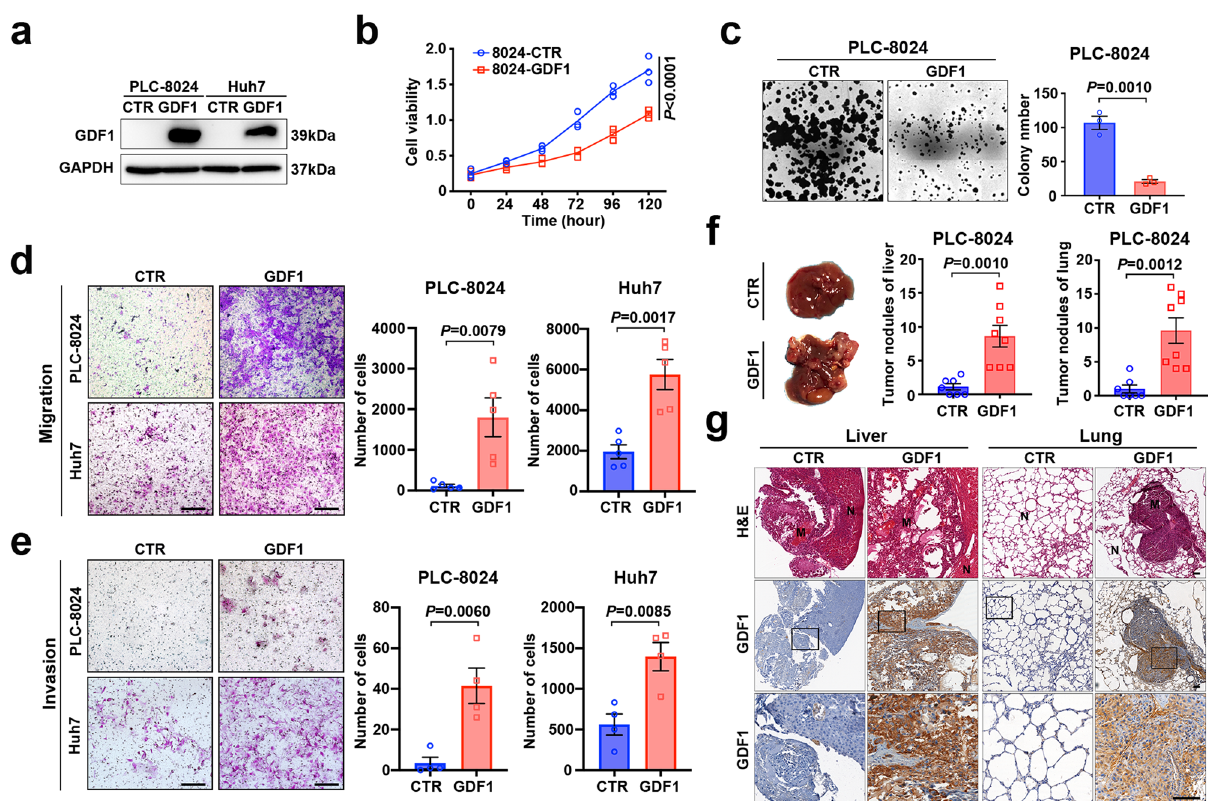
Fig. 2 GDF1 suppressed HCC cell proliferation but strongly induced tumour metastasis. a PLC-8024 and Huh7 cells were stably transfected with full- length GDF1, and overexpression was con fi rmed at the protein level by western blot ( n = 3 independent experiments). b A cell-viability assay was performed to evaluate the cell proliferation rate in PLC-8024-CTR cells and PLC-8024-GDF1 cells (two-way ANOVA test, data are presented as mean values ± SEM, n = 3 independent experiments). c A colony-formation assay was performed to evaluate the colony formation ability of PLC-8024-CTR cells and PLC-8024-GDF1 cells (two-tailed independent Student ’ s t test, data are presented as mean values ± SEM, n = 3 independent experiments). d, e Cell migration ( d ) and invasion ( e ) abilities were measured in PLC-8024 cells and Huh7 cells stably transfected with or without GDF1 (two-tailed independent Student ’ s t- test, data are presented as mean values ± SEM, d : n = 5 independent experiments, e : n = 4 independent experiments). f A total of PLC-8024- CTR cells and PLC-8024-GDF1 cells were intrasplenically injected into immune-de fi cient BALB/c nude mice. Metastatic liver and lung tumour nodules were calculated 6 weeks later (two-tailed independent Student ’ s t -test, data are presented as mean values ± SEM, PLC-8024-CTR: n = 7, PLC-8024-GDF1: n = 8). g H&E staining and IHC staining of GDF1 were performed in metastatic liver and lung tumour nodules (PLC-8024-CTR: n = 7, PLC-8024-GDF1: n = 8). Scale bars represent 200 µ m. Source data are provided as a Source Data fi